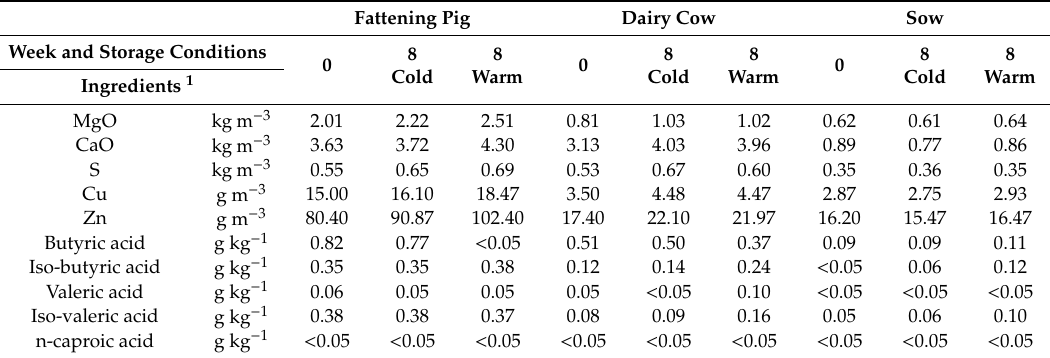
Table A1. Additional characteristics of fattening pig, dairy cow and sow slurry (fresh material) in week 0 and 8 depending on cold (4.7 ± 1.1 ◦ C) and warm storage conditions (23.6 ± 2.1 ◦ C).